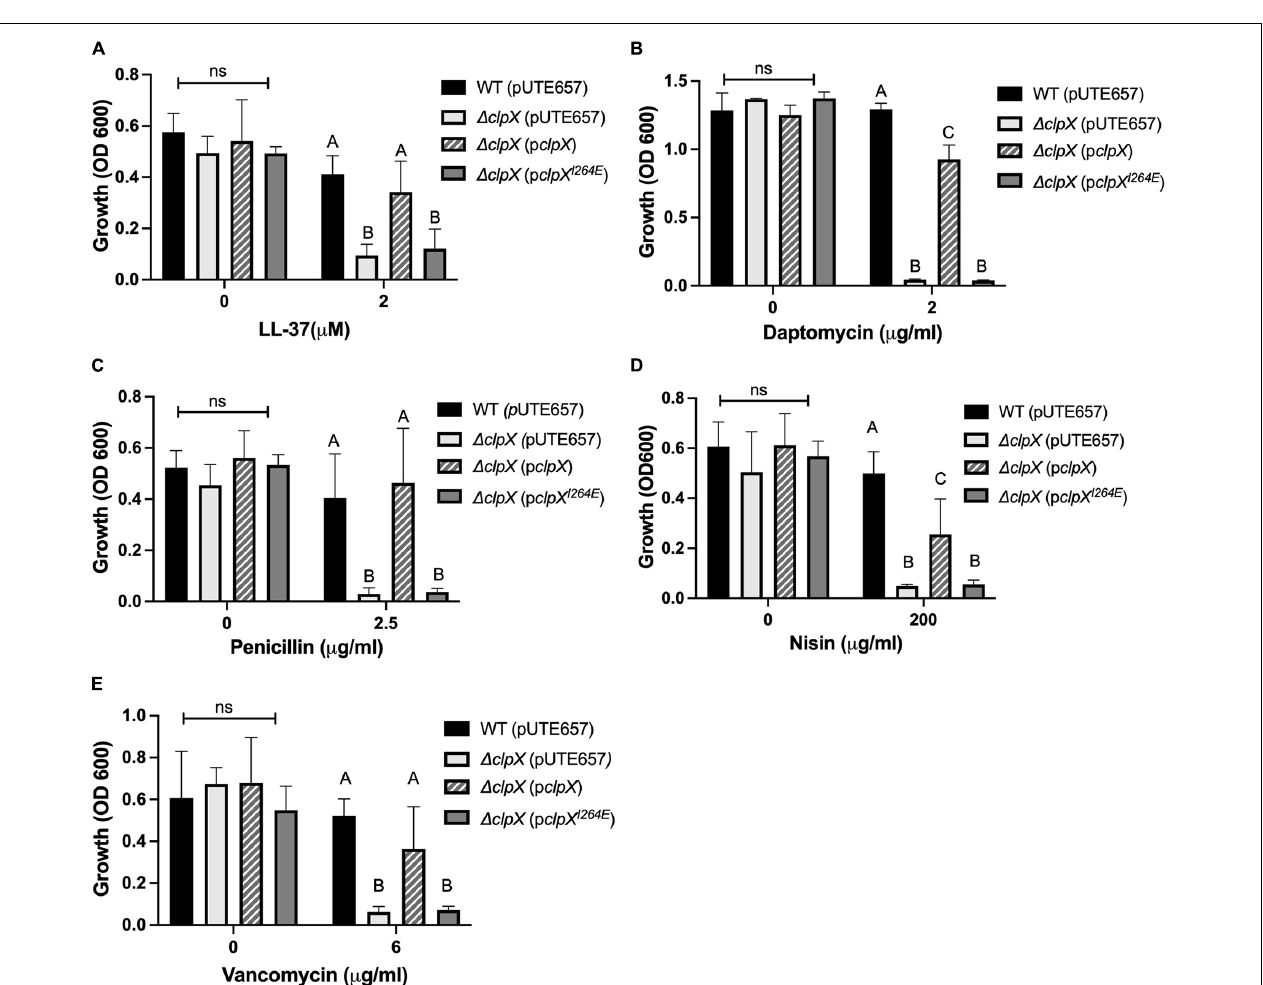
FIGURE 1 | Formation of the ClpXP protease is necessary to maintain antimicrobial resistance in B. anthracis Sterne. Overnight growth of wild-type B. anthracis Sterne (WT), (cid:49) clpX mutant containing the empty plasmid (pUTE657), and (cid:49) clpX complemented with either the wild-type clpX gene (p clpX ) or the clpX gene containing the I264E point mutation (p clpX I 264 E ) in media containing either (A) LL-37, (B) daptomycin, (C) penicillin, (D) nisin, or (E) vancomycin. Data are presented as mean ± SD and assays were repeated at least three independent times. Different numbers represent statistically significant differences ( p < 0.05) and ns indicates no statistical difference within each treatment group as determined by one-way ANOVA followed by Tukey–Kramer post hoc analysis.